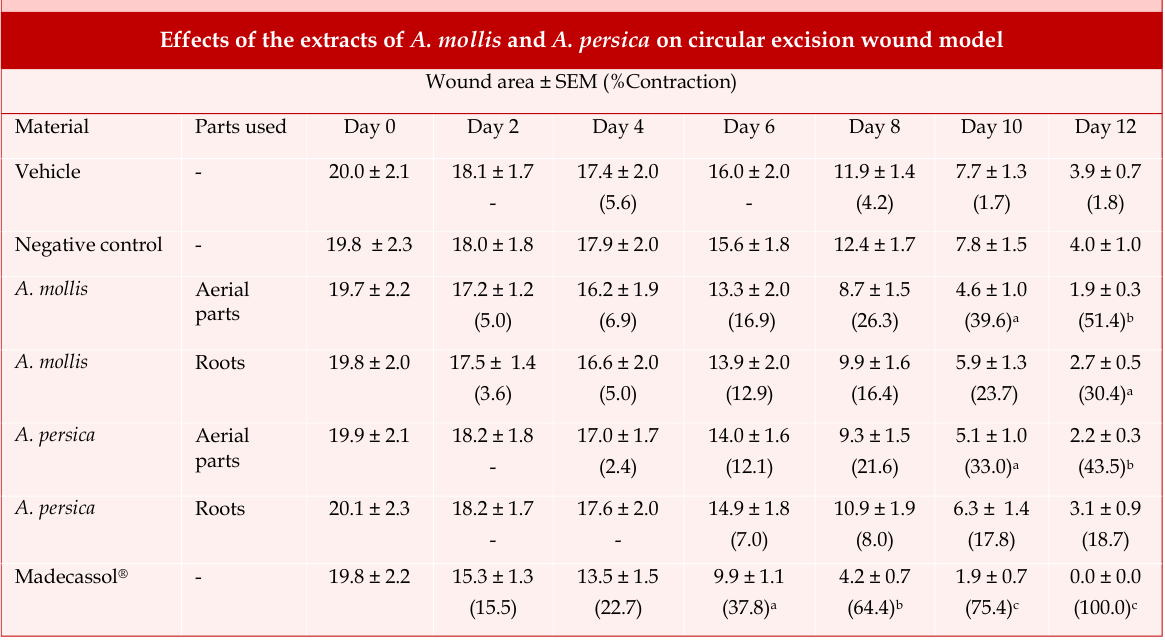
Effects of the extracts of A. mollis and A. persica on circular excision wound